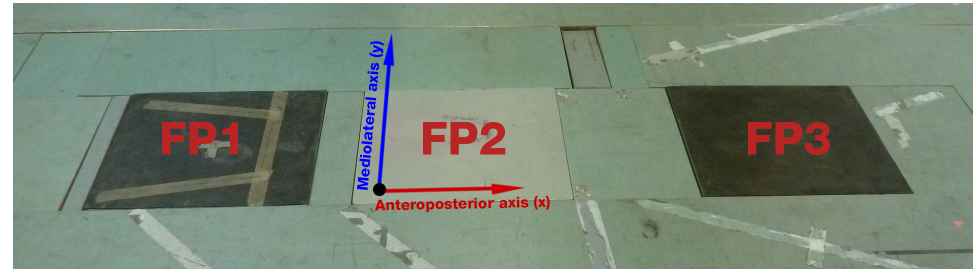
Figure 2. The three AMTI force plate system used, denoting the coordinate system of the laboratory. The vertical axis ( z ) points upwards, perpendicular to the anterior ( x ) and lateral ( y )